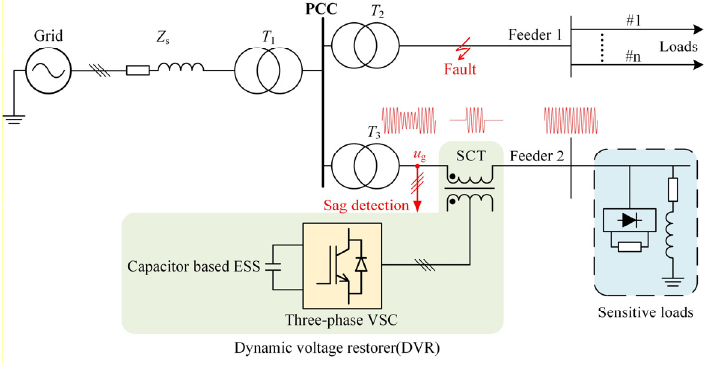
Figure 1. Schematic of DVR.